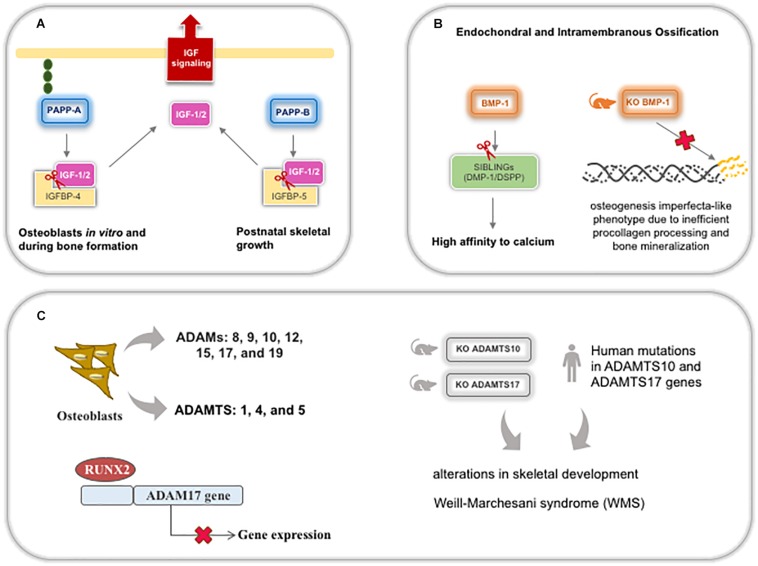
Schematic representation of metalloproteinases (except MMPs) expression and roles during bone development and postnatal skeletal growth. (A) PPAPP-A and B cleavage the complex IGFBP/IGFs to bioavailable IGF for bone cells. (B) BMP-1 is important for SIBLINGs cleavage, specifically DMP-1 and DSPP, leading these glycoproteins to increase their affinity to calcium and contributing for mineralization. (C) Several ADAMs and ADAMTSs are expressed by osteoblasts, being ADAM17 downregulated by RUNX2 during osteoblastic differentiation. Both ADAMTS10 and 17 knockout mice and human mutations display the same bone phenotype recognized in Weill-Marchesani syndrome. ADAM: adisintegrin and metalloproteinase; ADAMTS: adisintegrin and metalloproteinase with thrombospondin motifs; DMP-1: dentin matrix acidic phosphoprotein; DSPP: dentin sialophosphoprotein; IGFBP: insulin-like growth factor binding protein; IGF: insulin-like growth factor; KO: knockout mice; PAPP: pregnancy-associated plasma protein.